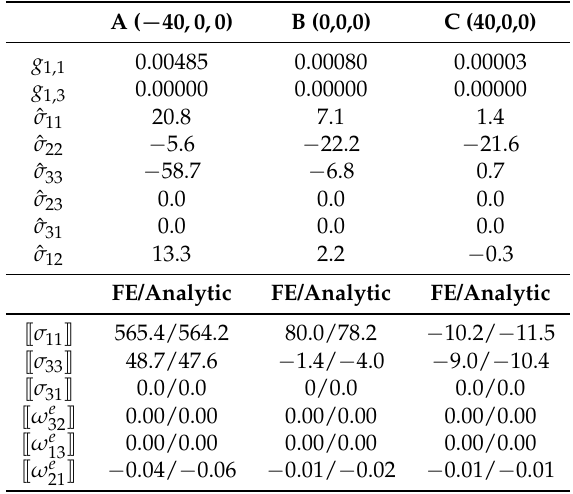
Table 4. Values of ˆ σ (MPa) provided by the FE simulation 4 and used to compute the analytic ∼ formulas (28)–(30) and (32) (top). Comparisons of the values of [[ σ simulation 4 and those computed from the analytic formulas